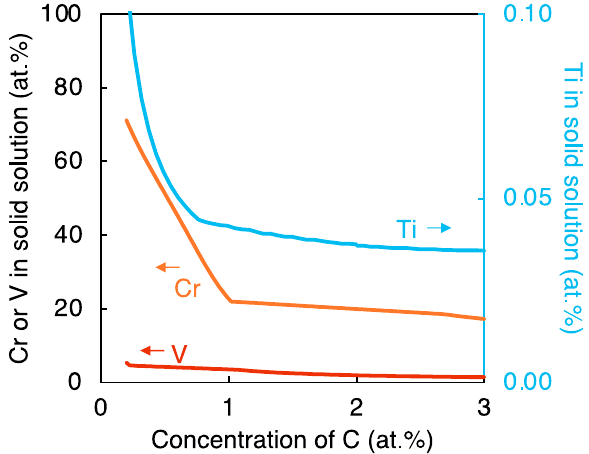
Figure 5. Simulated solubility product of V, Ti, and Cr carbides in Fe at 1473 K.